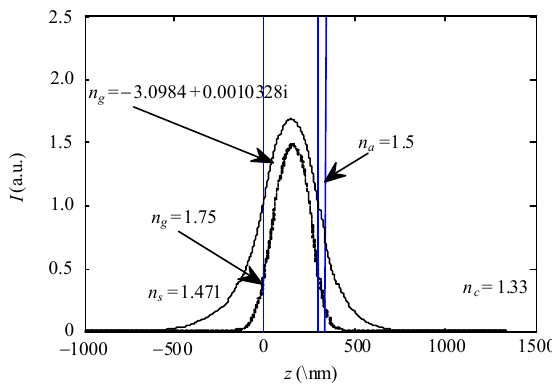
Fig. 2 Calculated TM mode profile of electromagnetic field for the proposed and conventional waveguide structures. The mode profile is shown for guiding layer thickness ( d g ) = 300 nm and adlayer thickness ( d a ). The refractive indices used in the simulation are: n s = 1.471, n a = 1.50, and n c =